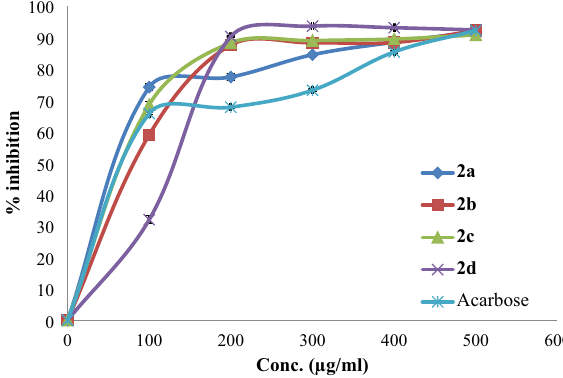
Figure 4. % Inhibition of α-glycosidase by the tested compounds.